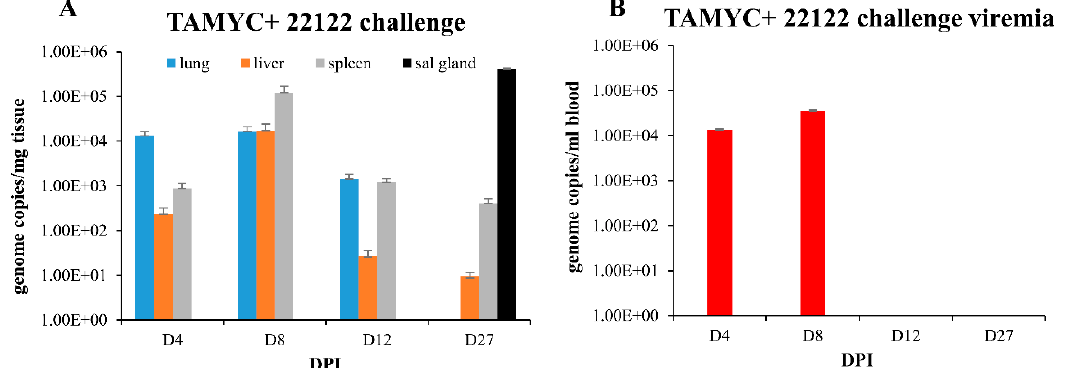
Figure 5. GPCMV pathogenesis in seropositive animals (TAMYC) challenged with heterologous virus strain (22122). Convalescent TAMYC seropositive animals ( n = 12) were challenged with 22122 GPCMV, 10 5 pfu SQ. At 4, 8, 12, and 27 dpi, 3 animals per group were evaluated for viral load in target organs by real-time PCR and plotted as viral genome copies / mg tissue ( A ). Salivary gland tissue was